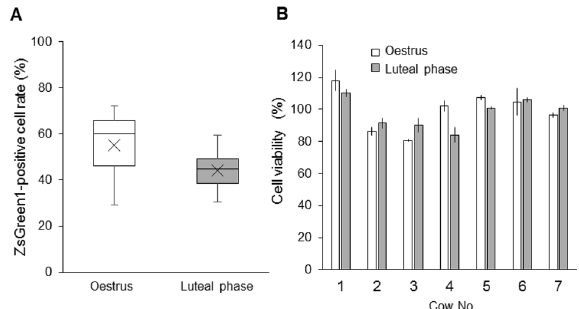
Figure 4. Comparison of lipofection efficiencies between BE-1 cells derived from oestrus and luteal phase. ( A ) BE-1 cells were prepared from seven cows in either the oestrus or the luteal phase. To compare the transfection efficiencies, ZsGreen1-expression vector (250 ng/well) was transfected into each set of BE-1 cells at P.5, using the TransFectin Lipid Reagent. The ZsGreen1-positive cell rate was measured at 48 hpt. Boxes indicate the first, the median and the third quartiles; whiskers indicate the minimum and maximum. ( ×) indicates the average value for all seven cows. There were no significant differences between the oestrus and luteal phase ( P = 0.706). ( B ) Cell viabilities were measured at 48 hpt.